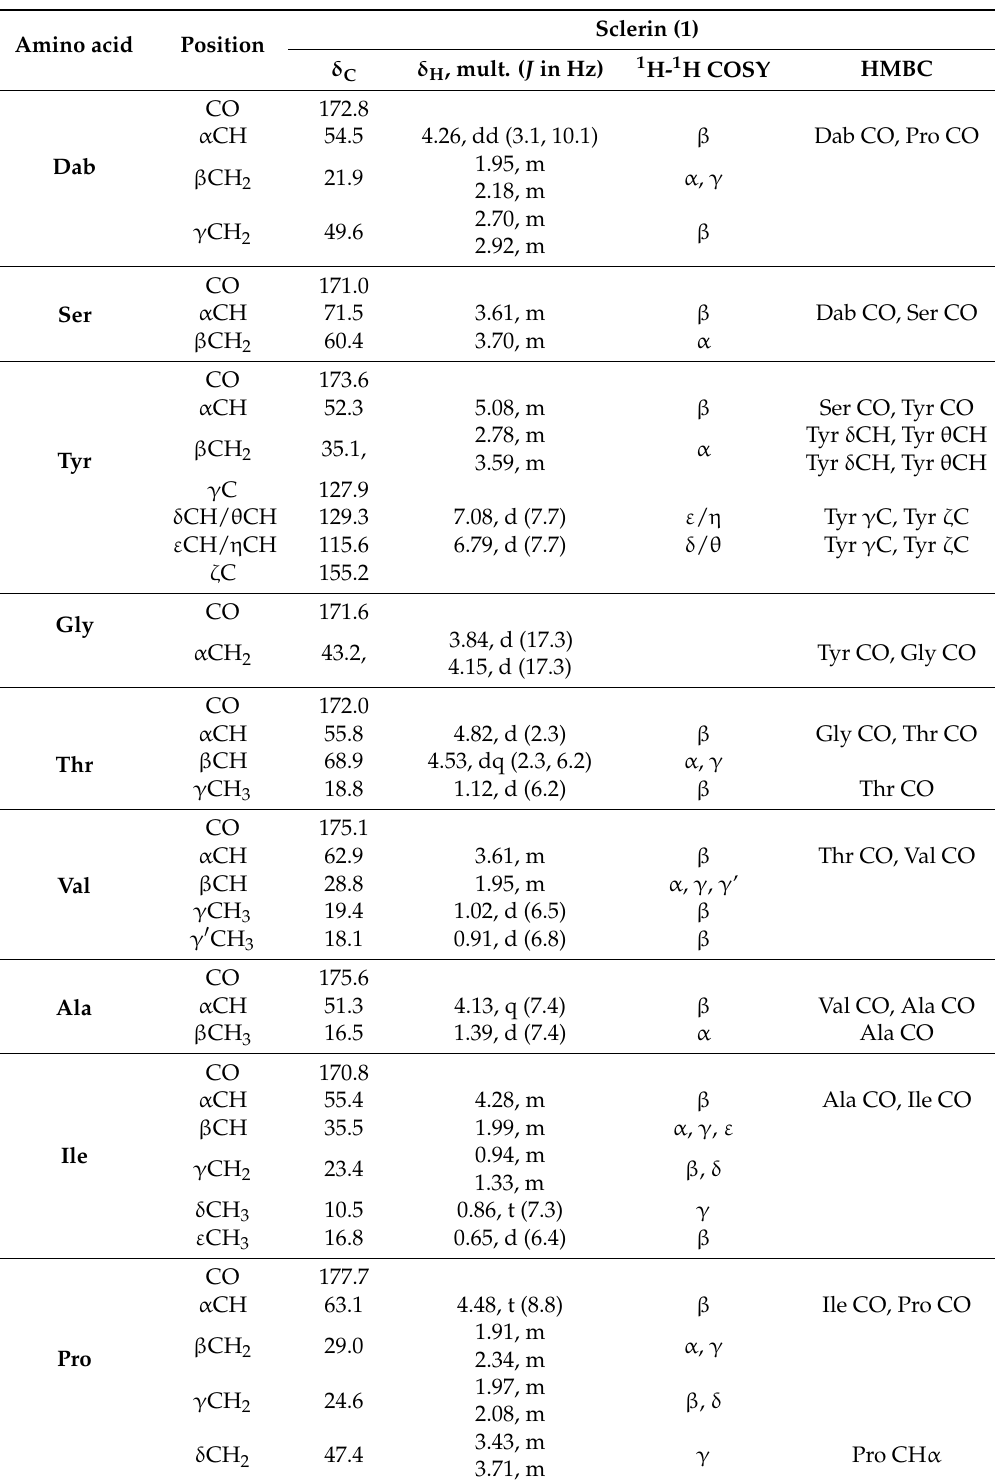
Table 1. NMR data (CD 3 OD) for cyclononapeptide sclerin ( 1